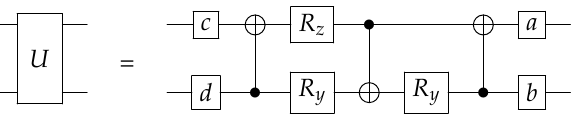
Figure 6. Minimal universal quantum circuit for a two-qubit gate using 18 elementary gates